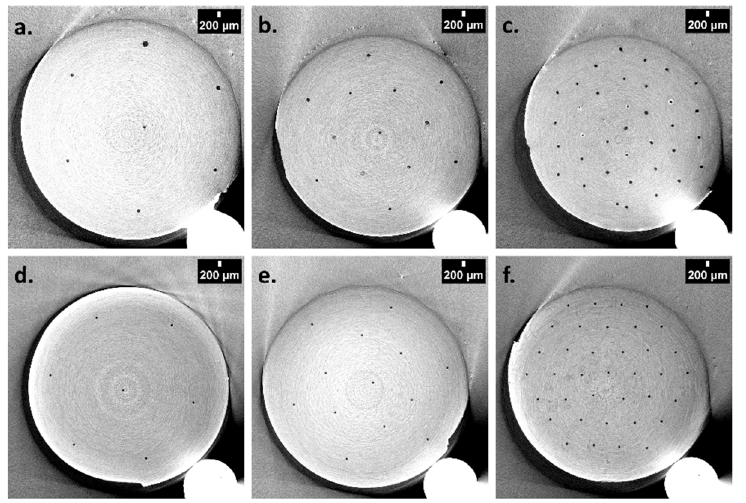
Figure 5. Tomographic images of oriented 120 µm-sized tubular macropores for 7 ( a ), 13 ( b ), and 37 ( c ) holes in HEMA-based materials and oriented 120 µm-sized tubular macropores for 7 ( d ), 13 ( e ), and 37 ( f ) holes in VMA-based materials.